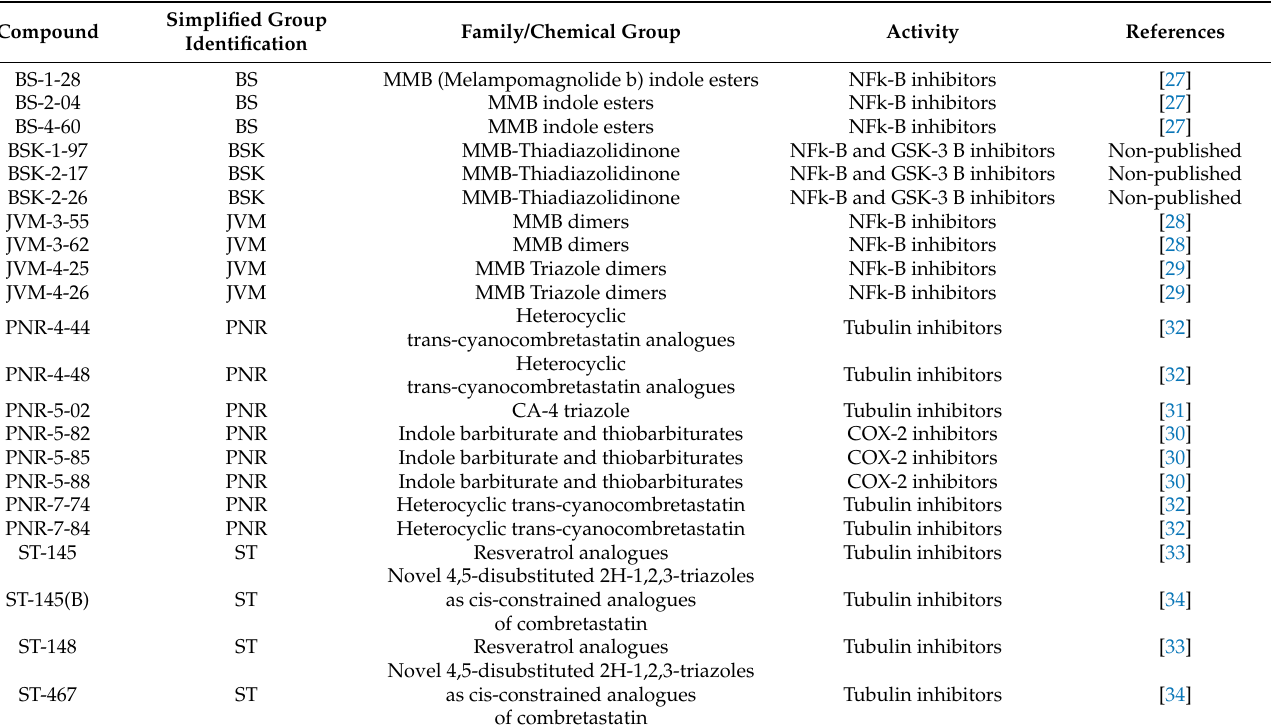
Table 1. Table Compounds/drugs Panel used for